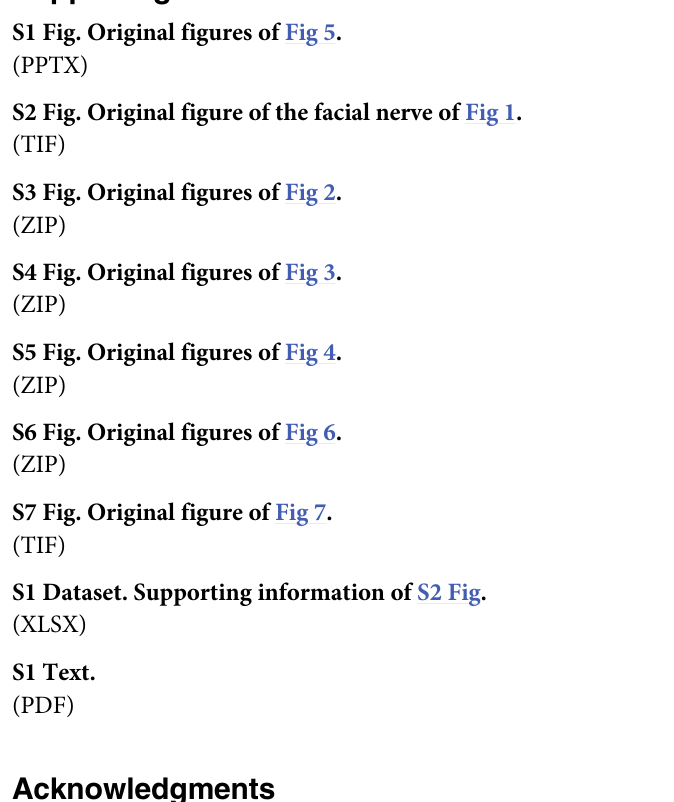
S1 Fig. Original figures of Fig 5. S2 Fig. Original figure of the facial nerve of Fig 1. S3 Fig. Original figures of Fig 2. S4 Fig. Original figures of Fig 3. S5 Fig. Original figures of Fig 4. S6 Fig. Original figures of Fig 6. S7 Fig. Original figure of Fig 7. S1 Dataset. Supporting information of S2